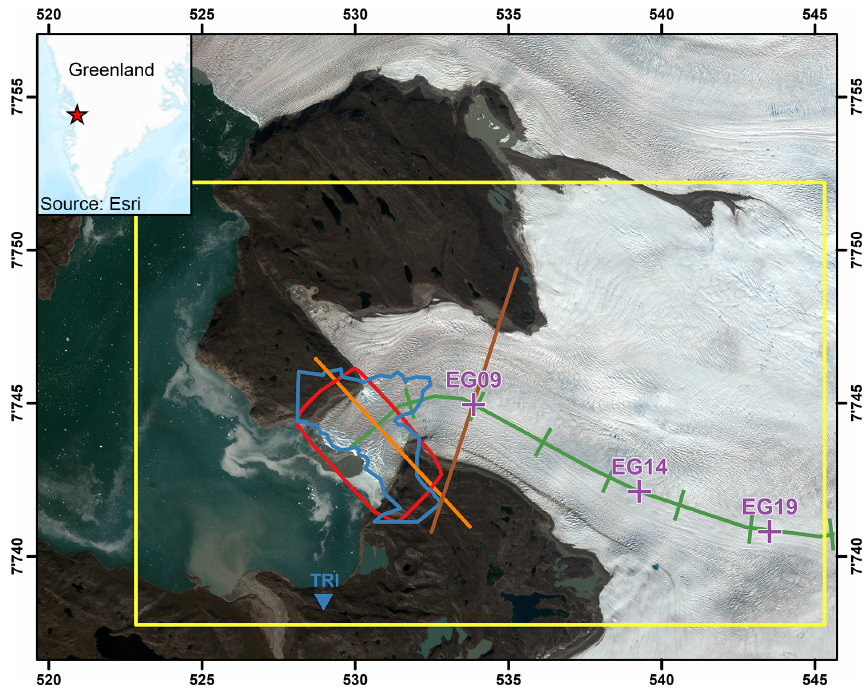
Figure 1. Eqip Sermia Glacier in western Greenland. The yellow area indicates the region evaluated in this study using spaceborne SAR images (S-1A and RADARSAT-2), with the red line showing the extent of the mosaic constructed using airborne UAV and the blue polygon depicting the area with mean ground-based backscatter coherence > 0 . 7 acquired from the terrestrial radar interferometer (TRI; its position is indicated with the blue triangle). The purple crosses mark the GPS tracker positions. The flowlines across the tongue are depicted in orange and brown (see Figs. 14 and 15). The green line depicts the central flowline with distance markers every 2500m, starting at the glacier’s terminus (see Fig. 13). Background: Sentinel-2A scene from 3 August 2016 (UTM 22N projection). This figure contains Copernicus Sentinel data